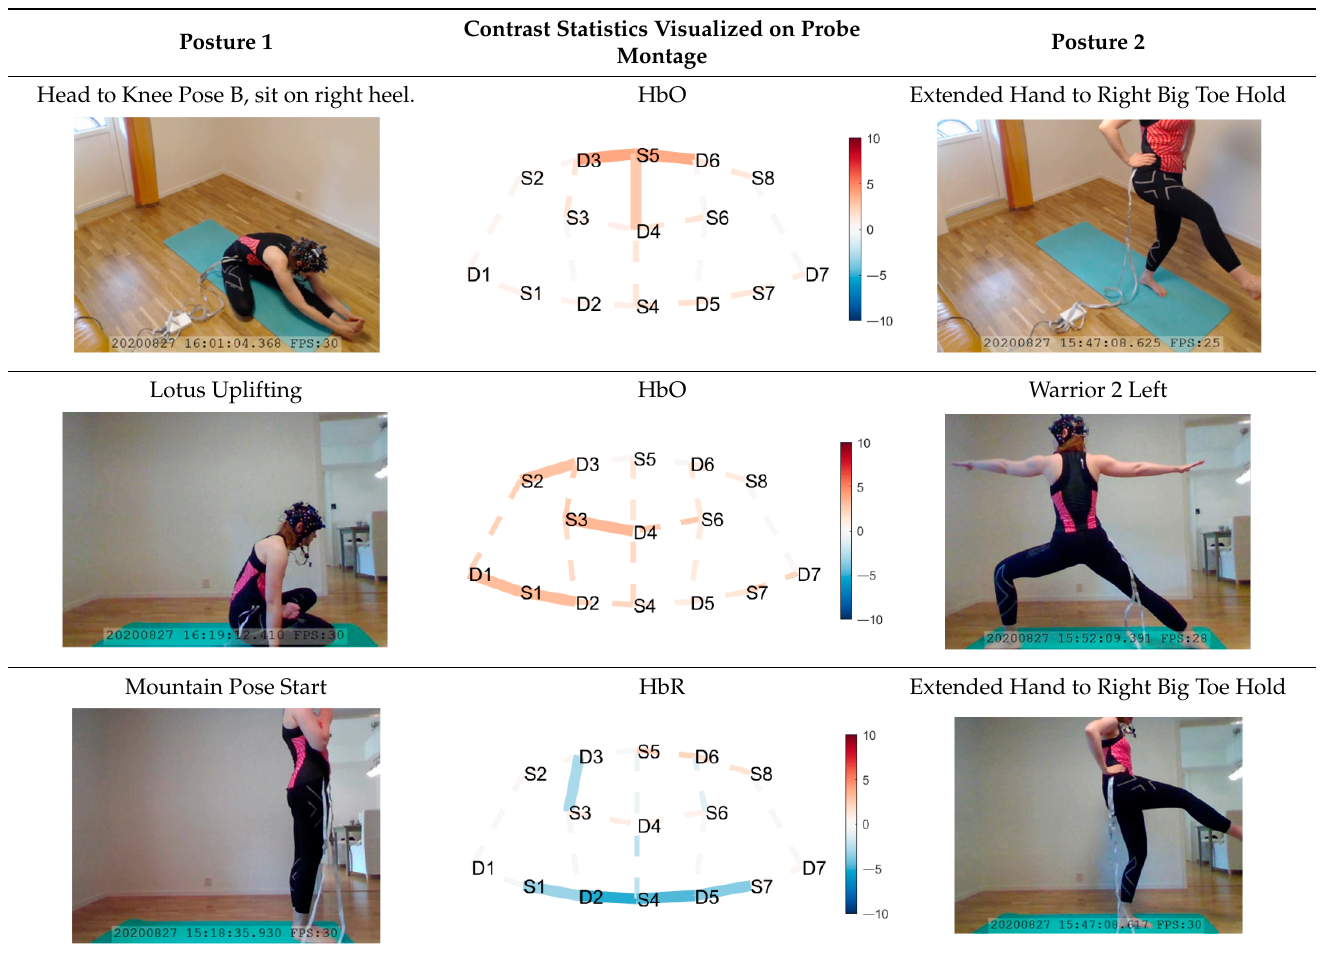
Table 2. Contrasts postures with middle significant differences. Contrasts are shown as t -tests of Posture 1 minus Posture 2 1 . Contrast Statistics Visualized on Posture 1 Posture 2 Probe Montage Head to Knee Pose B, sit on right heel.